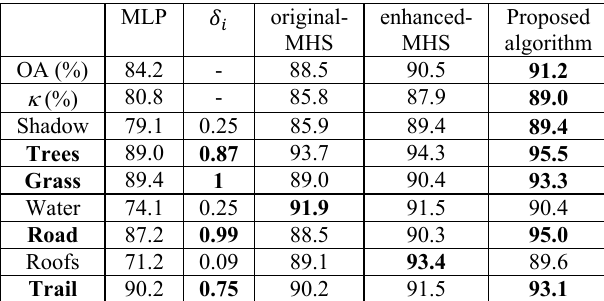
Table 1. The classification accuracies obtained on the Washington DC Mall